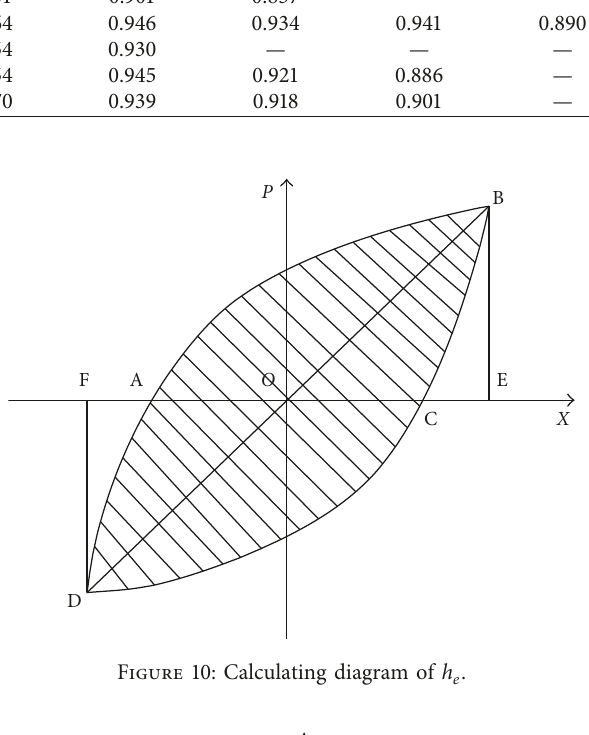
Figure 9: Stiffness degradation of the specimens.